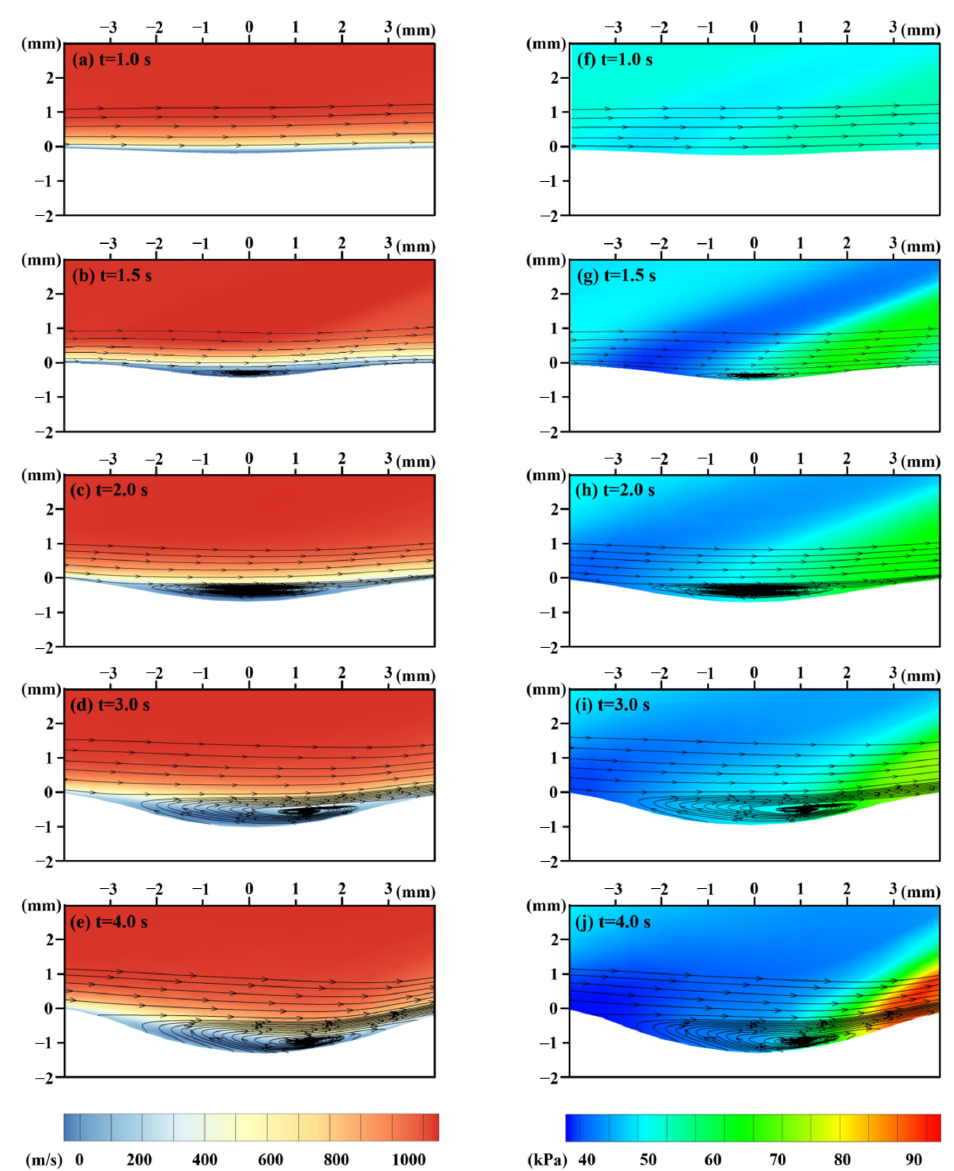
Figure 12. The contours and streamlines of flow velocity and pressure in the fluid domain.